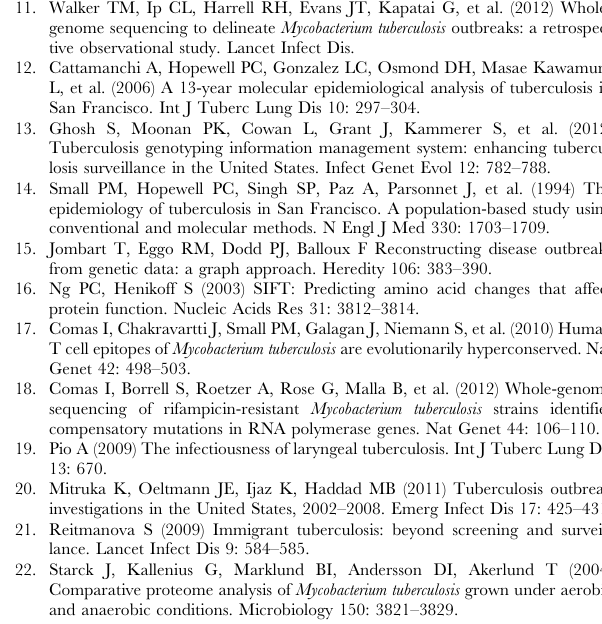
Table S1 Primers used to confirm the seven SNPs observed among the nine M. tuberculosis isolates. Table S2 GenBank Accession Number for each of the single nucleotide polymorphism (SNP) confirmed in each of the